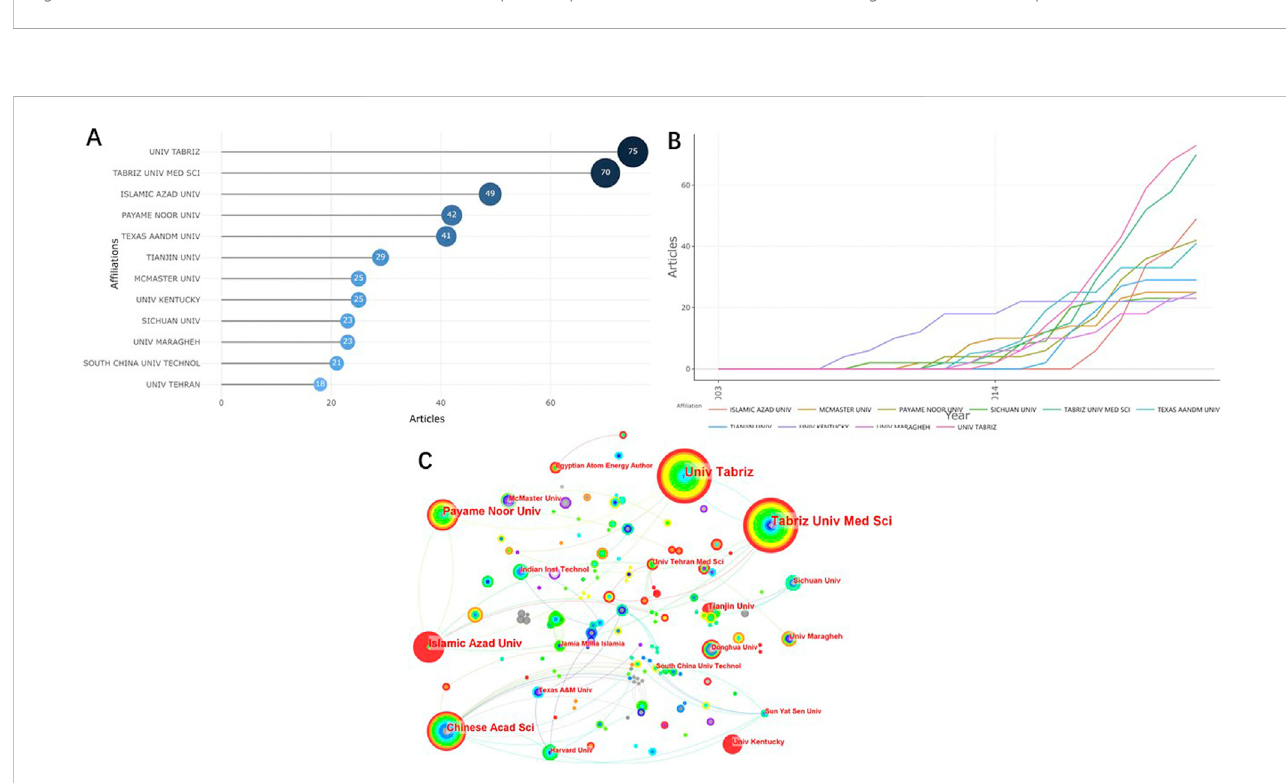
FIGURE 4 Visualized analysis of institutions concerning the publications of NHs applications for drug delivery. (A) The top 10 institutions with the most published papers; (B) Production of the top 10 institutions with the highest productivity over time. (C) The network map of cooperation relations between